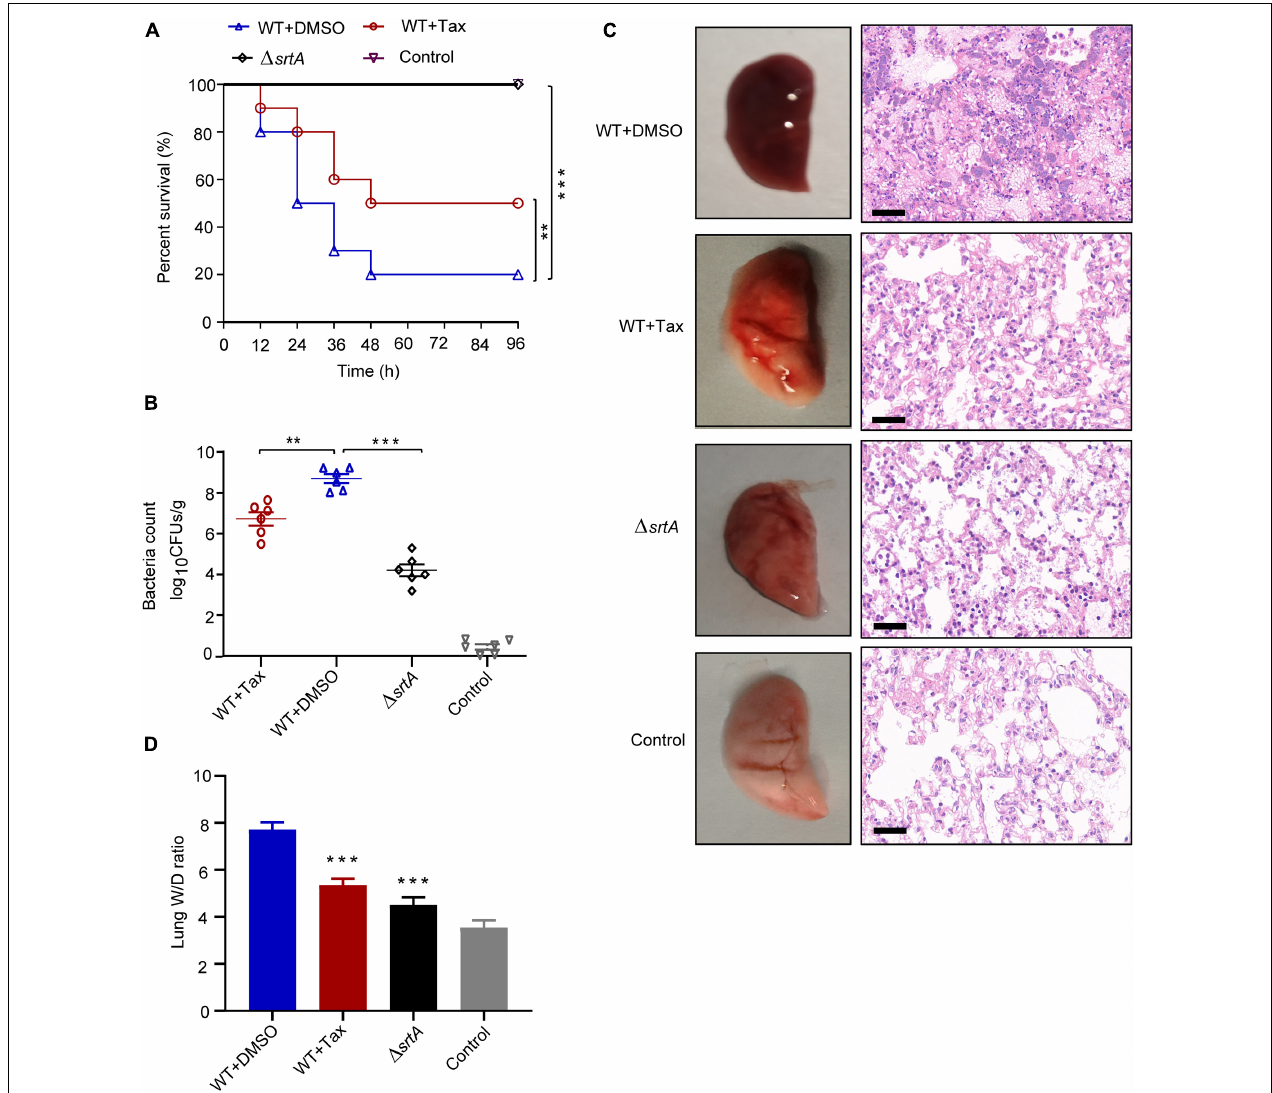
FIGURE 6 | Effect of treatment with Tax on S. aureus -induced pneumonia in mice. (A) Effect of Tax on the survival of mice ( n = 10 per group) infected with a lethal dose of S. aureus . (B) Effect of Tax (100 mg/kg) on bacterial load in the lungs of mice ( n = 6). (C) Gross pathological changes and histopathology of mouse lungs treated with Tax (100 mg/kg/d) or untreated. Scale bar: 50 µ m. (D) Lung wet-to-dry weight ratio (W/D). Each value represents mean ± SD ( n = 5 per group). ** P < 0.01, *** P < 0.001; Mann-Whitney test, two-tailed. Horizontal bars represent mean values. Animal data were obtained from two separate experiments.